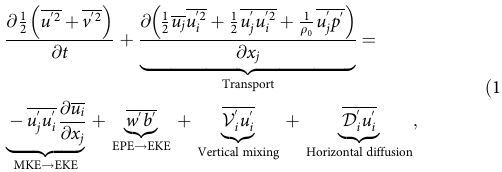
(cid:4) (cid:5) @ u i u 0 j i @ x j (cid:4) (cid:5) u 0 i i